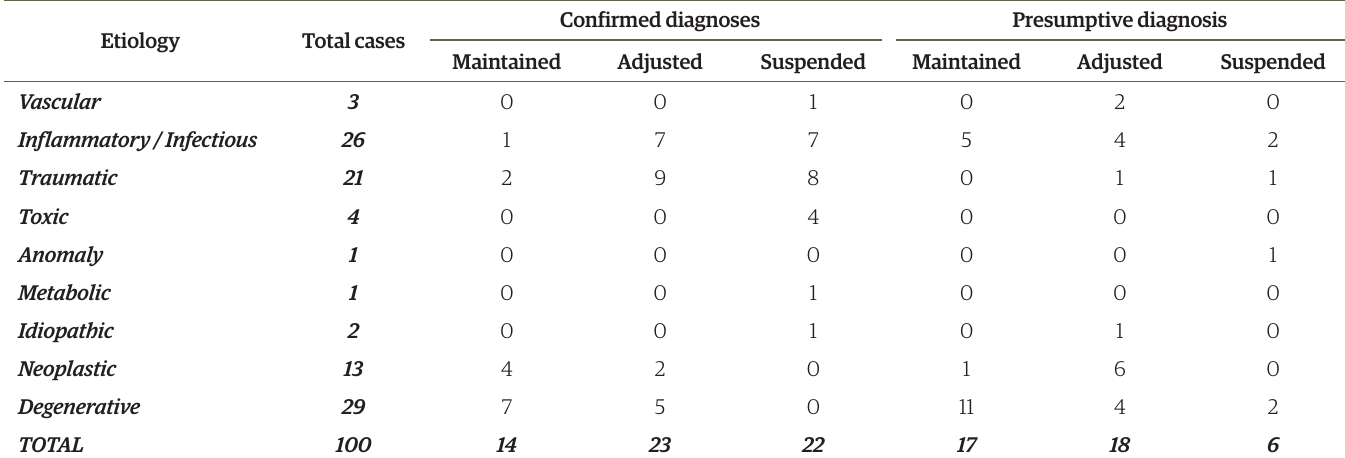
table 3. Characterization of the diagnoses, confirmed and presumptive, of dogs with neurologic diseases referred with a corticosteroid prescription (n = 100) to the Neurology Service at the Veterinary Hospital of UFRRJ, from August 2017 to April 2019. Seropédica, RJ.